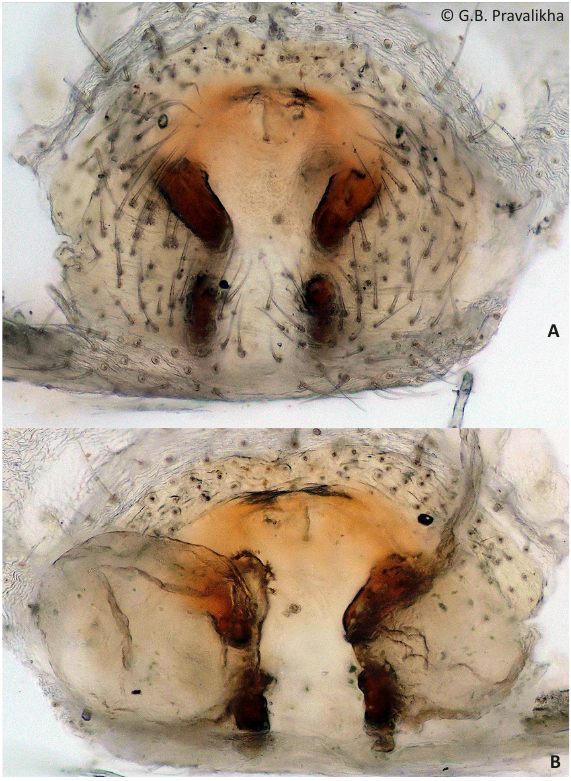
Figure 2 A-B. Thomisus projectus Tikader, 1960 epigyne, line drawing showing balloon like spermathecae (Sp) connected to genital openings (GO). A - external view; B - internal